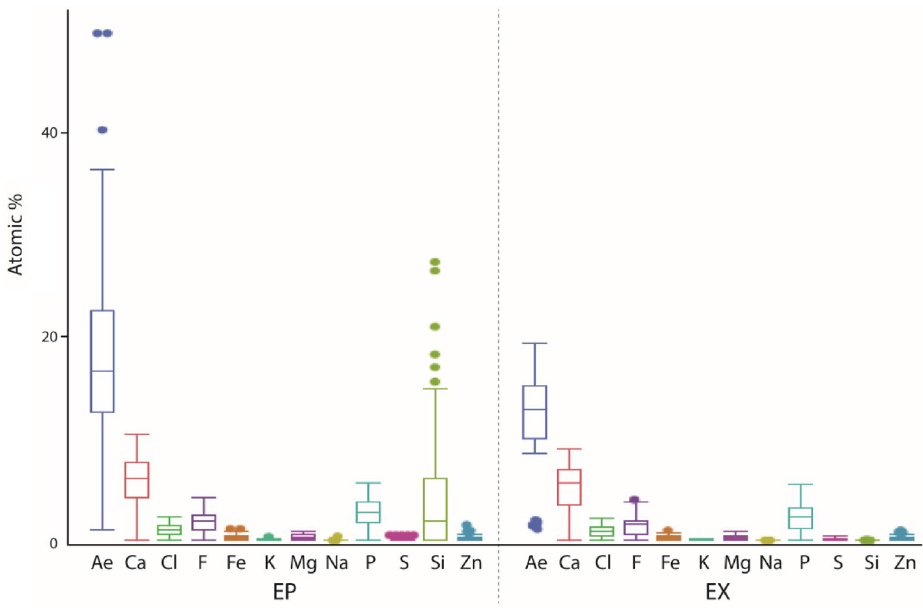
Figure 7. The results of elemental analysis (EDX) of the epicuticle and exocuticle (all structures studied are pooled together) (for exact values, see Table 2). The elemental proportions of Ae, Ca, Cl, F, Fe, K, Mg, Na, P, S, Si, and Zn are presented in atomic %. Ae all elements, EP epicuticle, EX